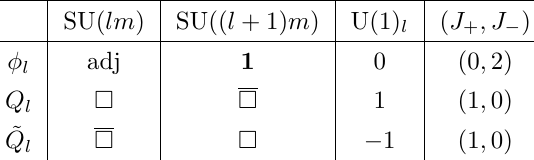
Table 2. l = 1 , . . . , N − 1 . The first two columns denote the gauge group factors, except that the last l = N − 1 entry SU( mN ) is a flavor symmetry group. The U(1) acting on the